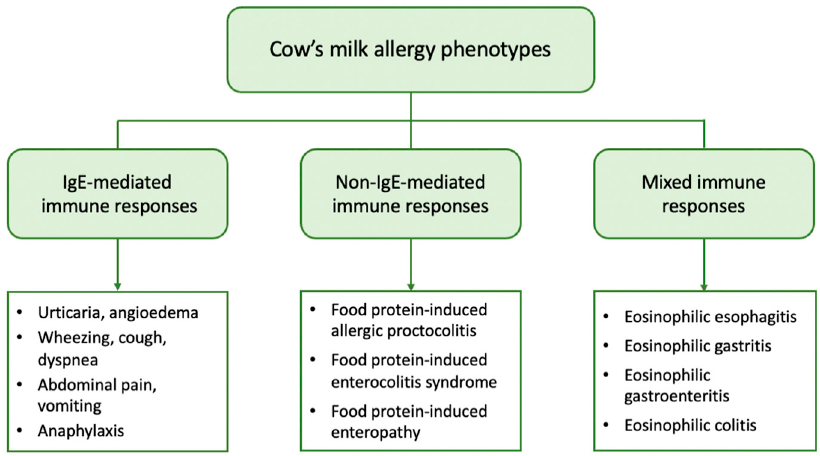
Figure 1. Clinical phenotypes of cow’s milk allergy.